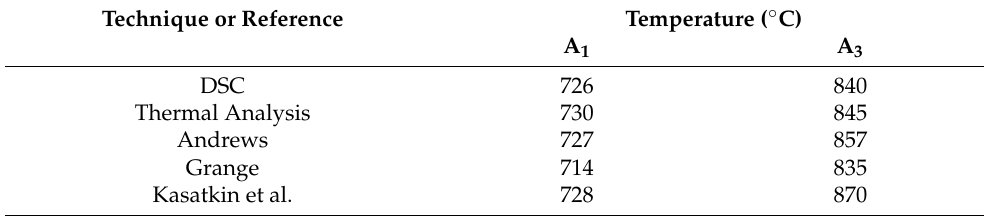
Table 2. Values of A 1 and A 3 , experimentally obtained and computed by means of empirical equations [18]. Technique or Reference